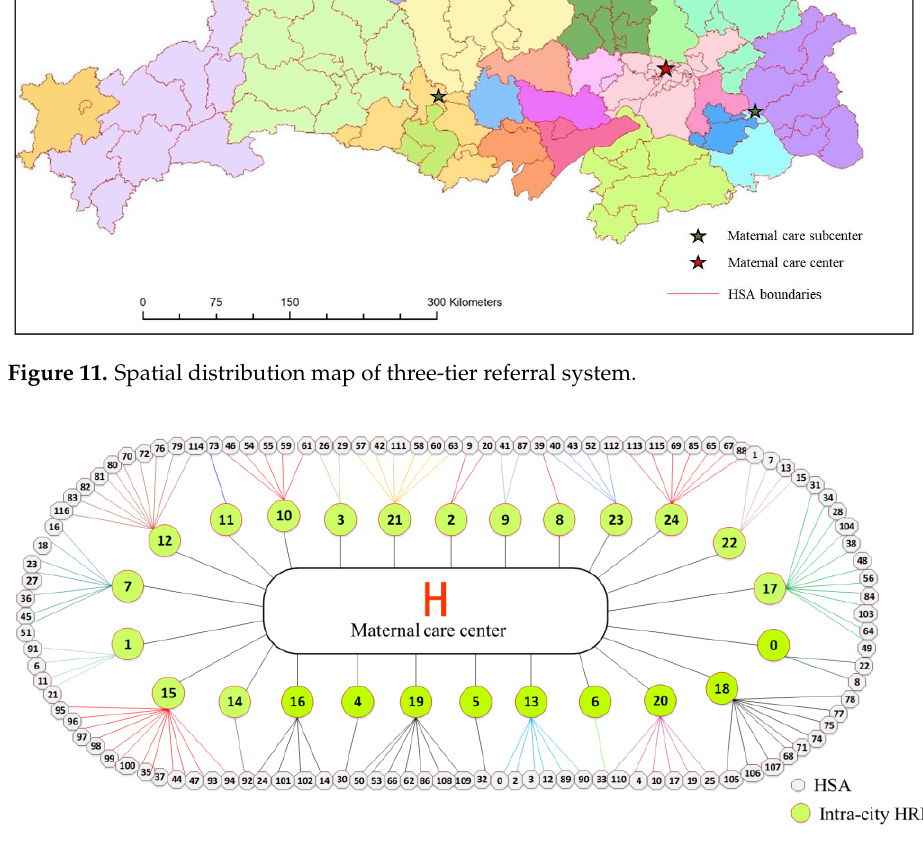
Figure 12. Three-tier system of referral